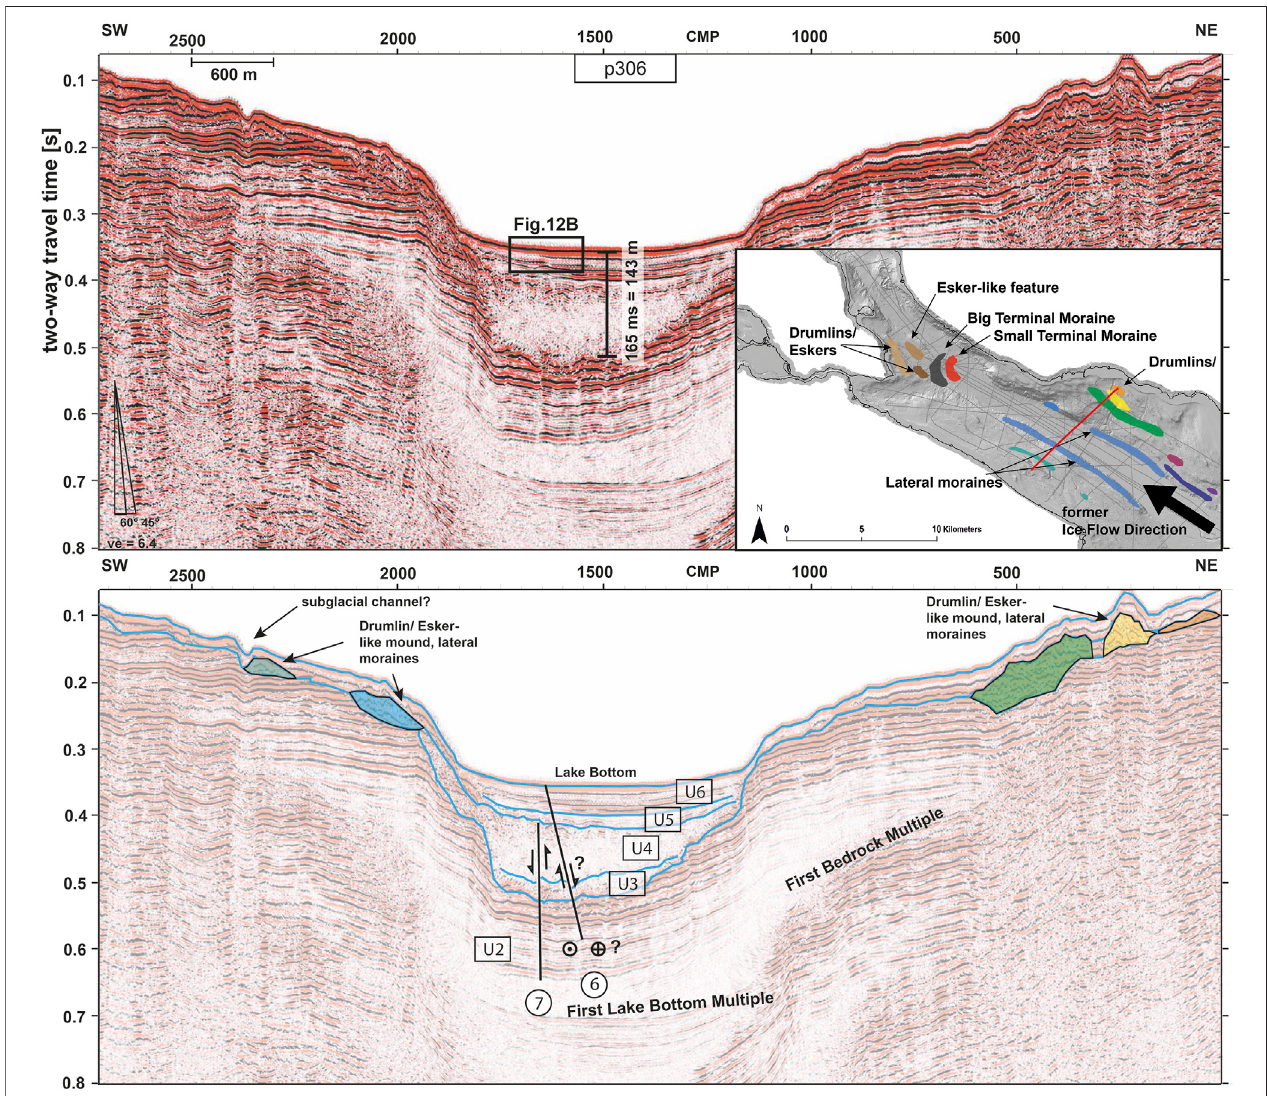
FIGURE 7 | top: Seismic section p306 (2017 vintage) crossing the central Obersee Basin with fi ve stratigraphic units (location in Figure 3 ). The sedimentary basin in fi llof165 ms( ∼ 140 m)wascalculatedbasedonanintervalvelocitymodel( SupplementaryTableS3 ).Bottom:Interpretationofp306withprominentglacialtilldeposit (colored polygons) on the northeastern and southwestern molasses fl anks. Shown faults are part of fault planes FID 6 and FID 7 (circled numbers, see details in Supplementary Table S5 ) with possible relation to major strike-slip fault structure (e.g., SFZ). Inset shows extent of seismic section (red line) and mapped till deposits (colored according to interpretation at the bottom) along OB. Black arrow indicates former ice fl ow direction.